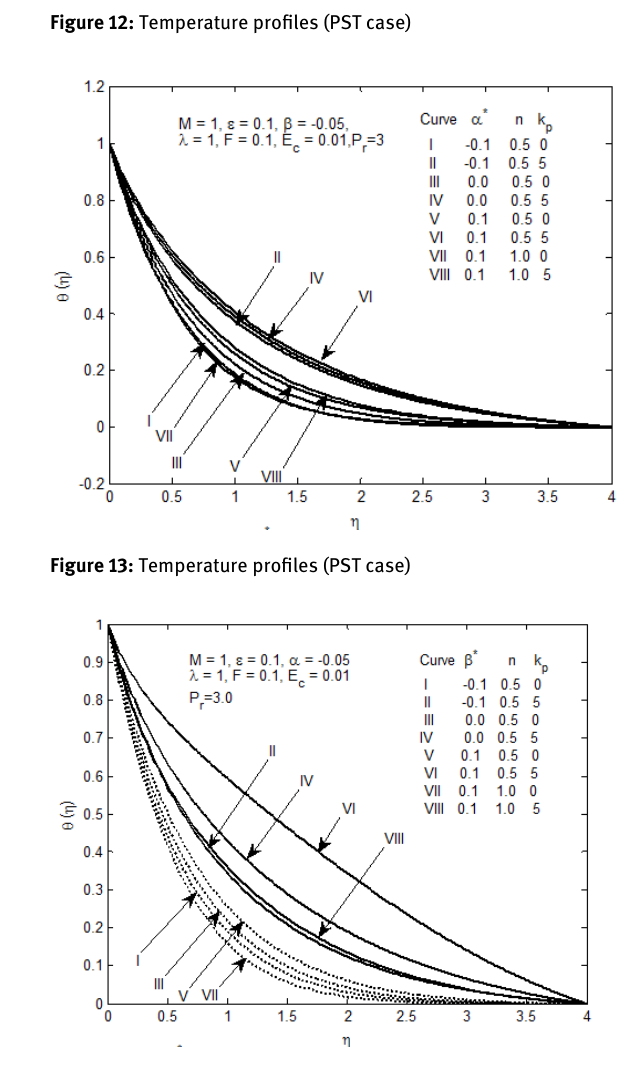
Figure 14: Temperature profiles (PST